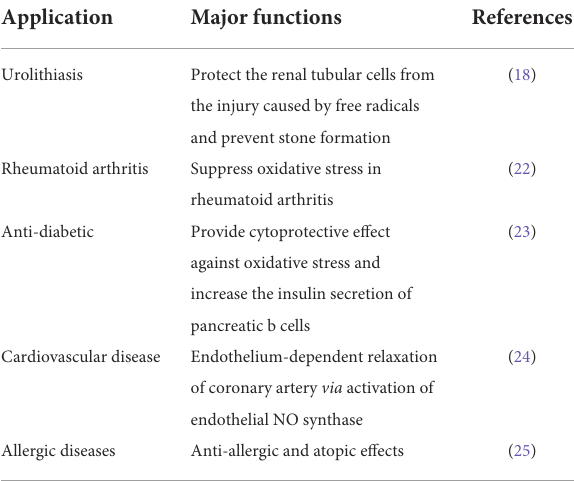
TABLE 1 Major medical functions and applications of QS